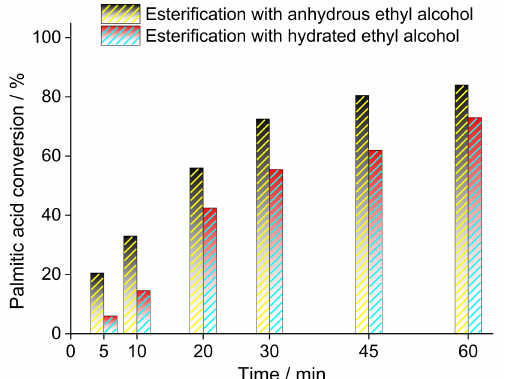
Figure 13. Palmitic acid esterification over Niobium oxide in anhydrous ethyl alcohol or hydrated (4 wt% water). Reaction conditions: alcohol: palmitic acid molar ratio (3:1), catalyst (20% wt% in relation to the fatty acid), temperature (200 ◦ C) (adapted from